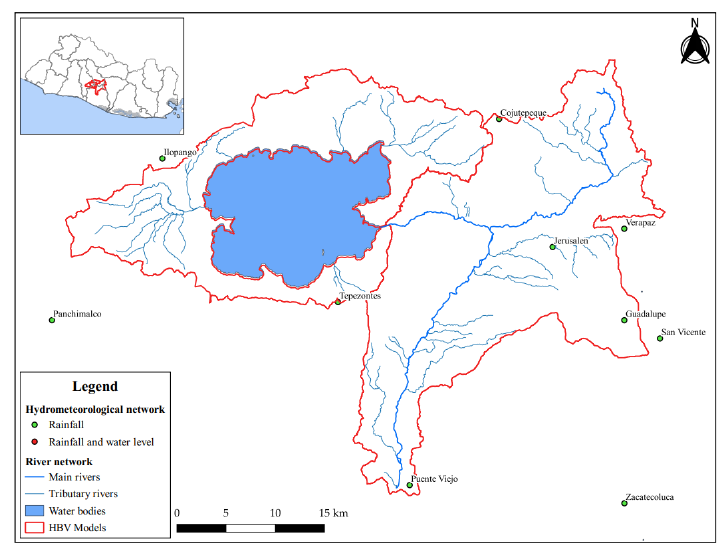
Figure 1. Jiboa and Lake Ilopango catchment area that drains to Puente Viejo water level gauge and the surrounding rainfall gauges.